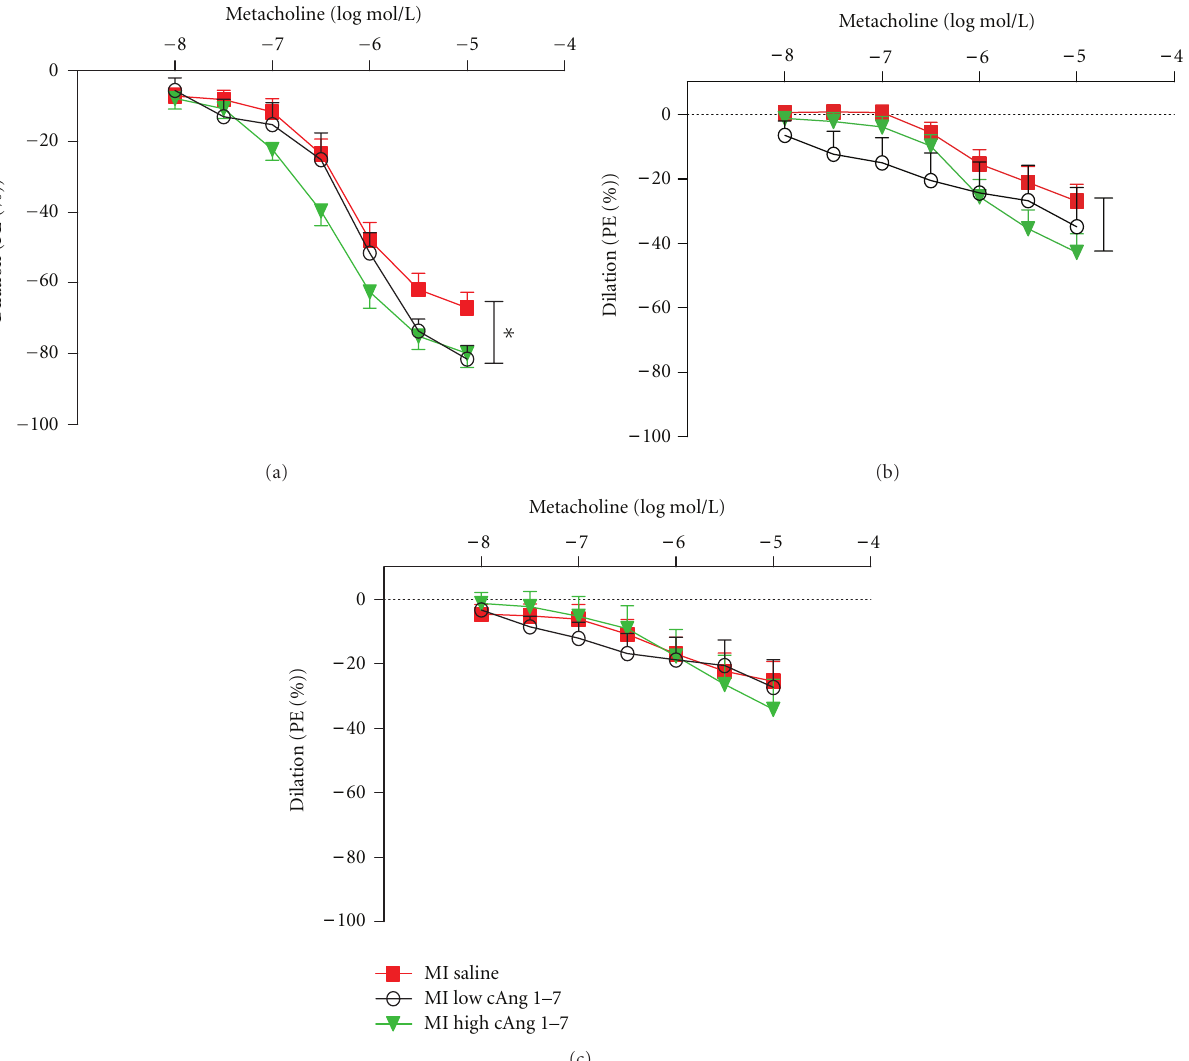
Figure 3: Endothelial-dependent dilator function of rat aorta to metacholine (a), after blockade of eNOS/NO signaling (b), and after combined blockade of eNOS/NO and EDHF vasodilator mechanisms (c). ( ∗ P < 0 . 05,